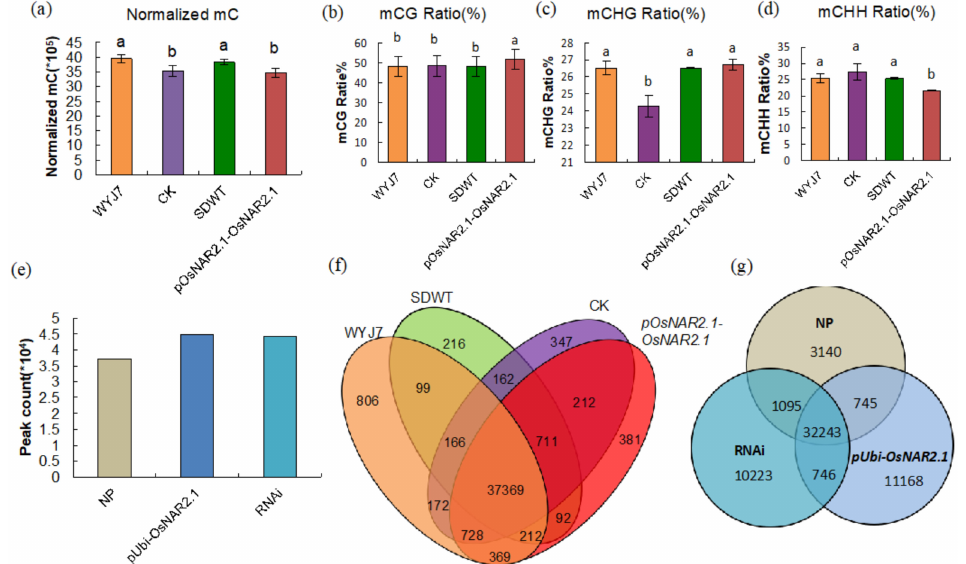
Figure 1. Characteristics of sequencing data ( a ) Normalized DNA cytosine methylation numbers in WYJ7, CK, SDWT and pOsNAR2.1-OsNAR2.1 samples. ( b - d ) mCG, mCHG and mCHH ratio in WYJ7, CK, SDWT and pOsNAR2.1-OsNAR2.1 samples. ( e ) Peak count of methylation in NP, pUbi-OsNAR2.1 and RNAi. ( f ) Venn diagram of unique and shared genes in CpG methylation states for WYJ7, CK, SDWT and pOsNAR2.1-OsNAR2.1 samples. ( g ) Venn diagram of peaks in NP, RNAi and pUbi-OsNAR2.1